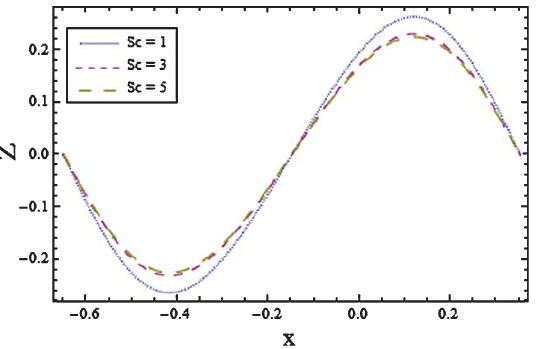
Fig. 18. Plot of heat transfer coefficient Z for various values of the Soret number Sr with (cid:15) = 0 . 1, t = 0 . 1 , Sc = 1 , Du = 2 , γ = 1 , γ = 10 , Pr = 1 . 5 and γ = 8. 1 2